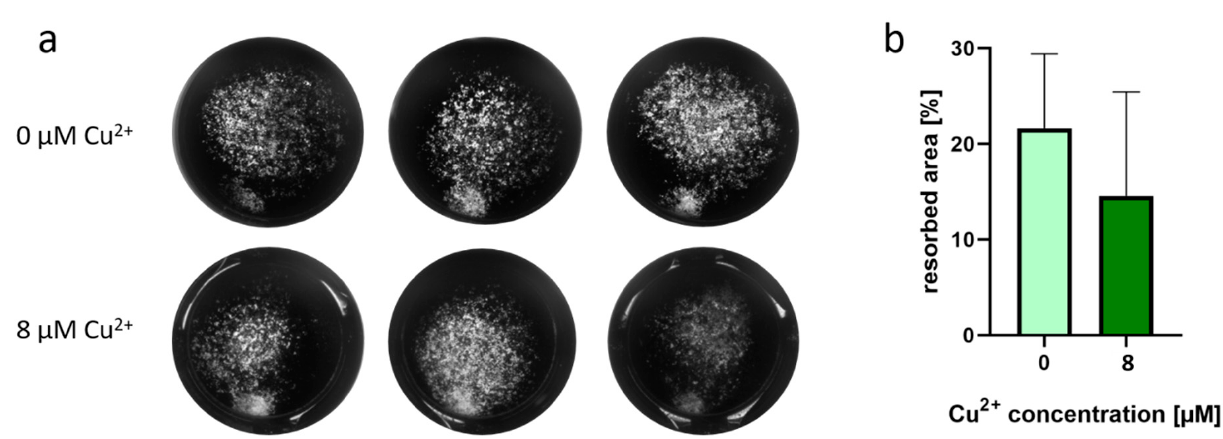
Figure 9. ( a ): Representative images of osteoblast-derived ECM after osteoclastic resorption in the presence of 8 µM Cu 2+ compared to a copper-free control. SaOS-2 osteoblasts were cultivated for 4 weeks until a closed layer of mineralized extracellular matrix was formed in the dishes. After re- moval of the osteoblasts, mature osteoclasts, detached from suspension dishes (two donors, each n = 3 per group) were seeded and cultivated for 4 days under further stimulation with M-CSF and RANKL with and without addition of 8 µM Cu 2+ . After fixing with 4 % formaldehyde, von Kossa staining was performed to stain the remaining mineralized matrix after osteoclastic resorption. Images were recorded with a Leica stereomicroscope and represent the whole area of a 48- well dish (12 mm diameter). ( b ) Resorbed area of all samples was calculated applying the open source software Fiji using the threshold function. Six samples were imaged for each condition and are shown as mean +/ − standard deviation. Two-tailed unpaired t-test did not show significant differ- ences between 0 and 8 µM Cu 2+ .